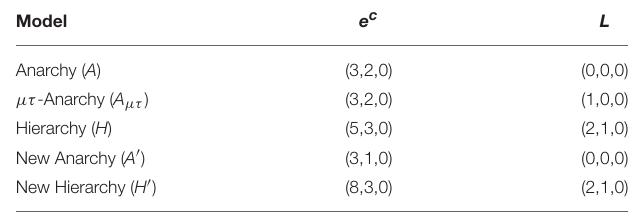
TABLE 4 | Examples of charge assignment under U